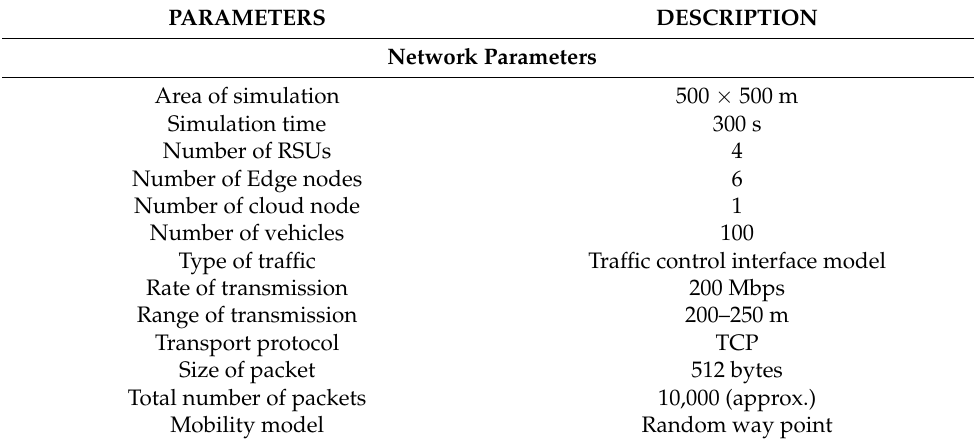
Table 6. Simulation